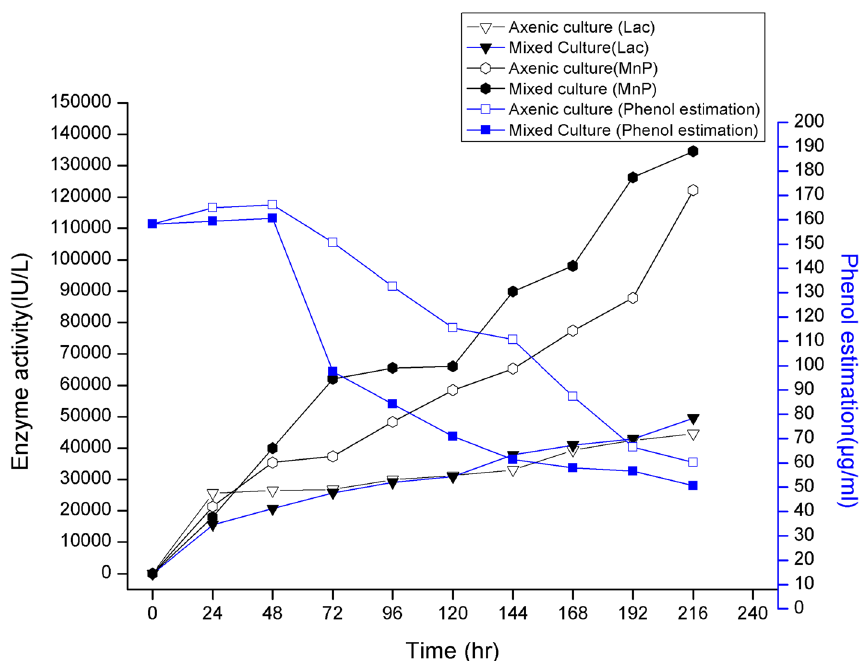
Fig. 5 Comparison of laccase activity (420 nm), MnP activity (610 nm) and total phenols (750 nm) in axenic and mixed culture, values are mean ± SE, n =